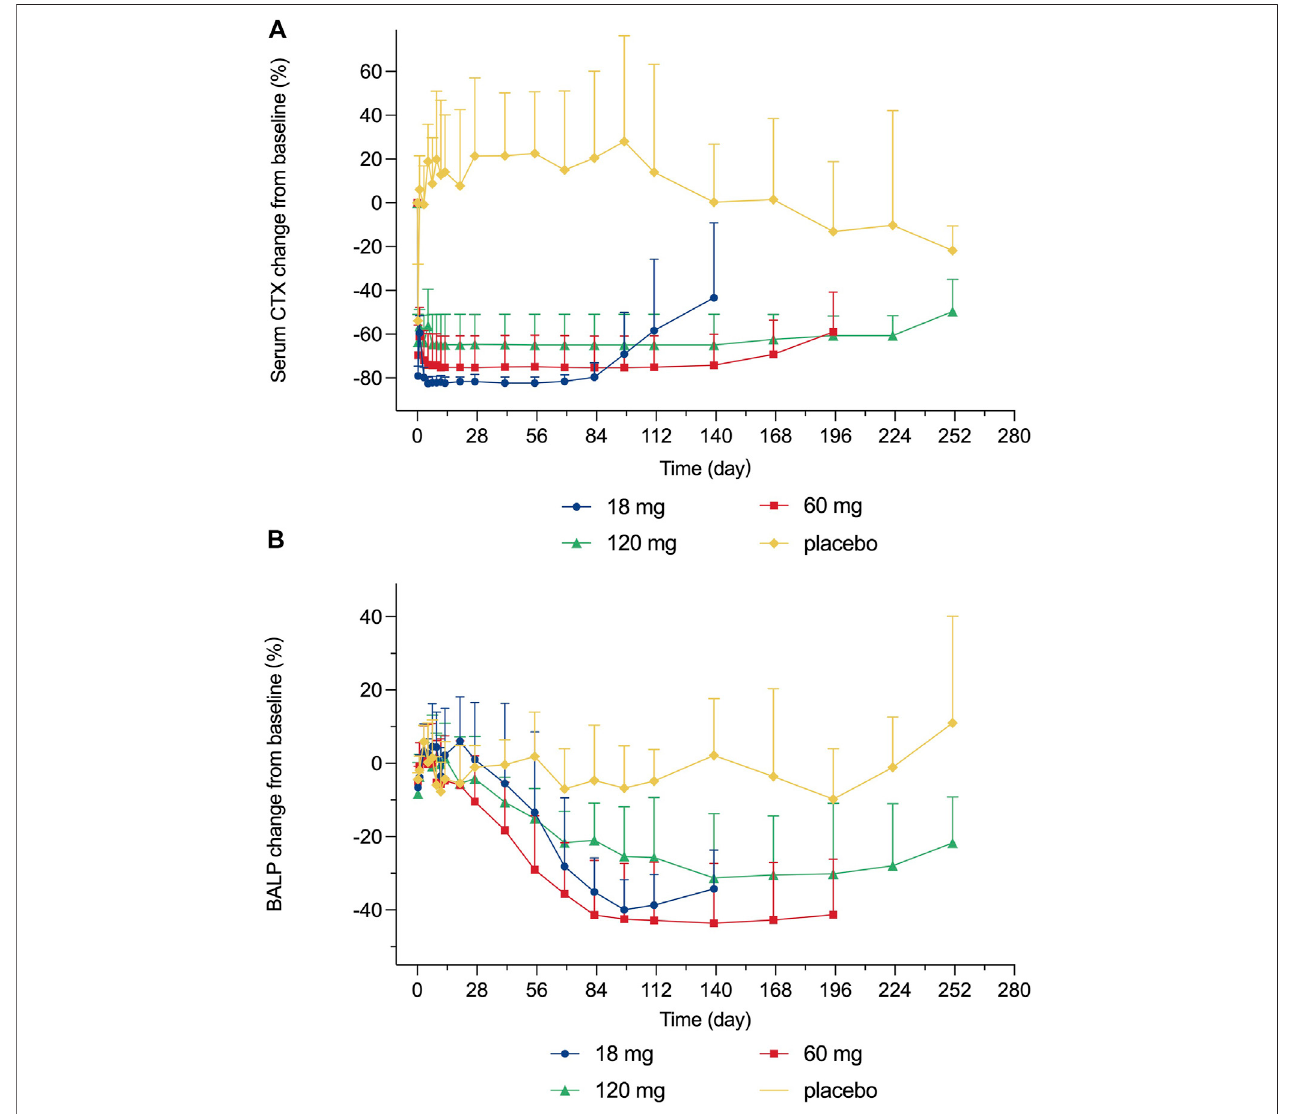
FIGURE 3 | Percent change from baseline in serum (A) CTX-1 concentration (B) BALP concentration.